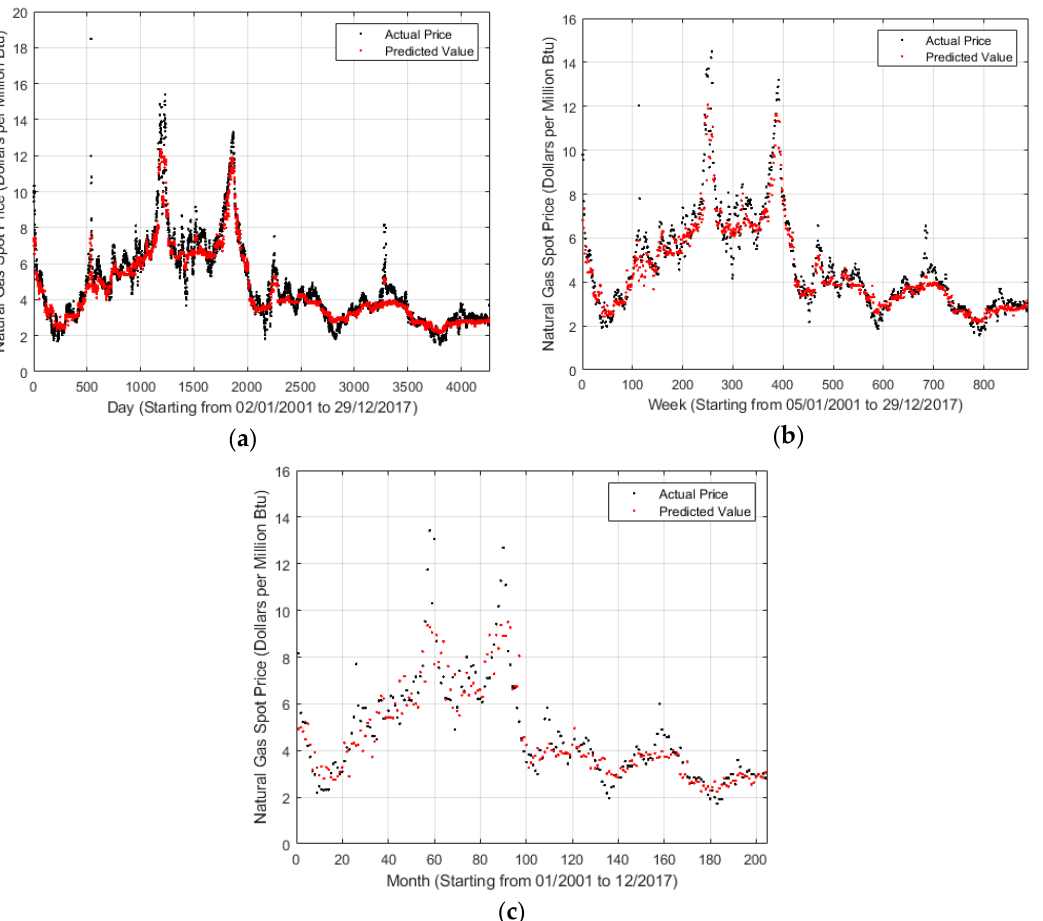
Figure 2. LSBoost outputs for different timescales. ( a ) Daily; ( b ) Weekly; ( c ) Monthly.